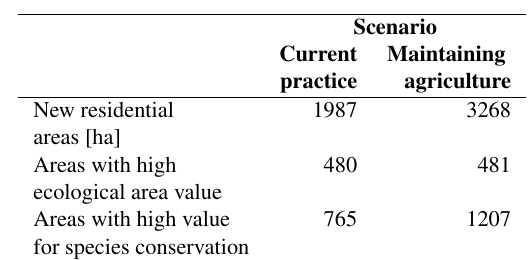
Figure 3. Feature importance of the random forest model, measured by the mean increase in impurity. The vertical bars indicate the standard deviation of the impurity decrease across the trees.